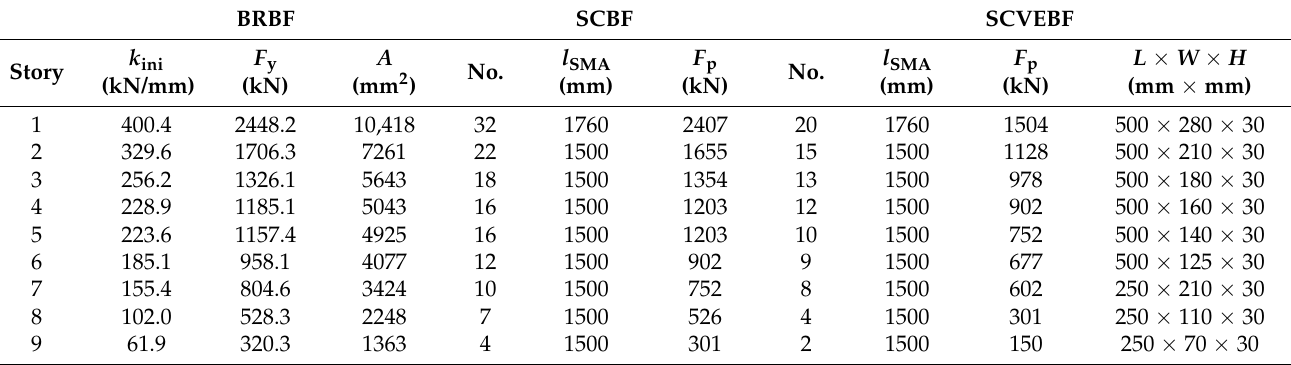
Table 1. Basic information of